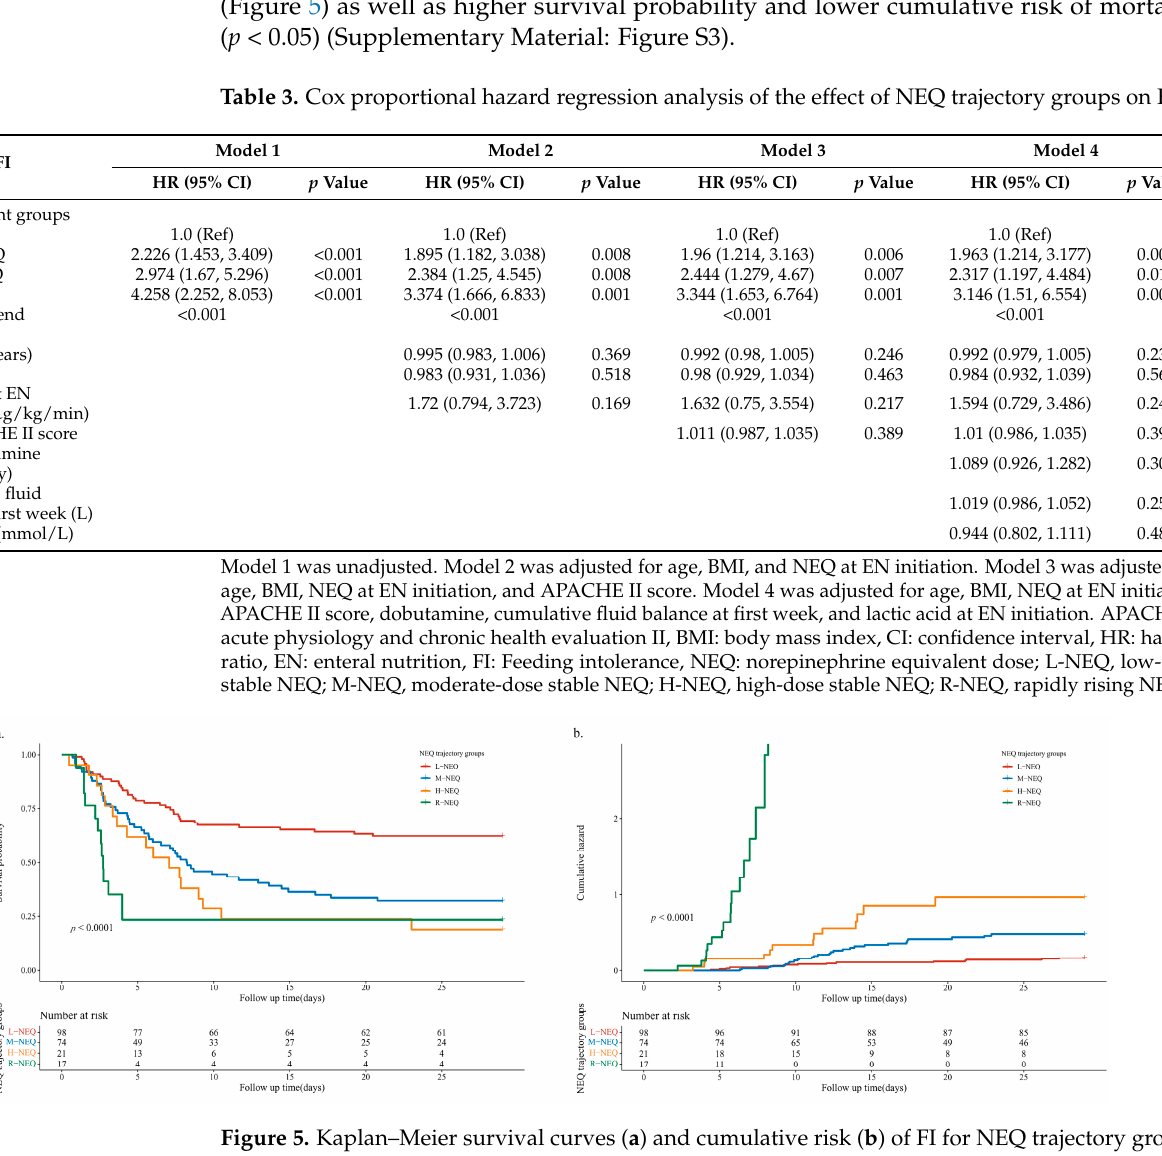
Figure 5. Kaplan–Meier survival curves ( a ) and cumulative risk ( b ) of FI for NEQ trajectory groups. NEQ, norepinephrine equivalent dose; L-NEQ, low-dose stable NEQ; M-NEQ, moderate-dose stable NEQ; H-NEQ, high-dose stable NEQ; R-NEQ, rapidly rising NEQ.